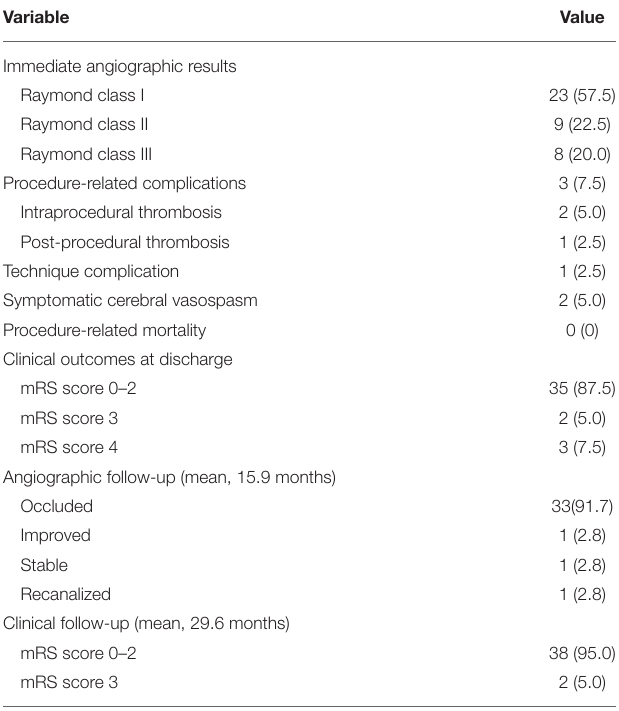
TABLE 2 | Treatment outcomes and follow-up